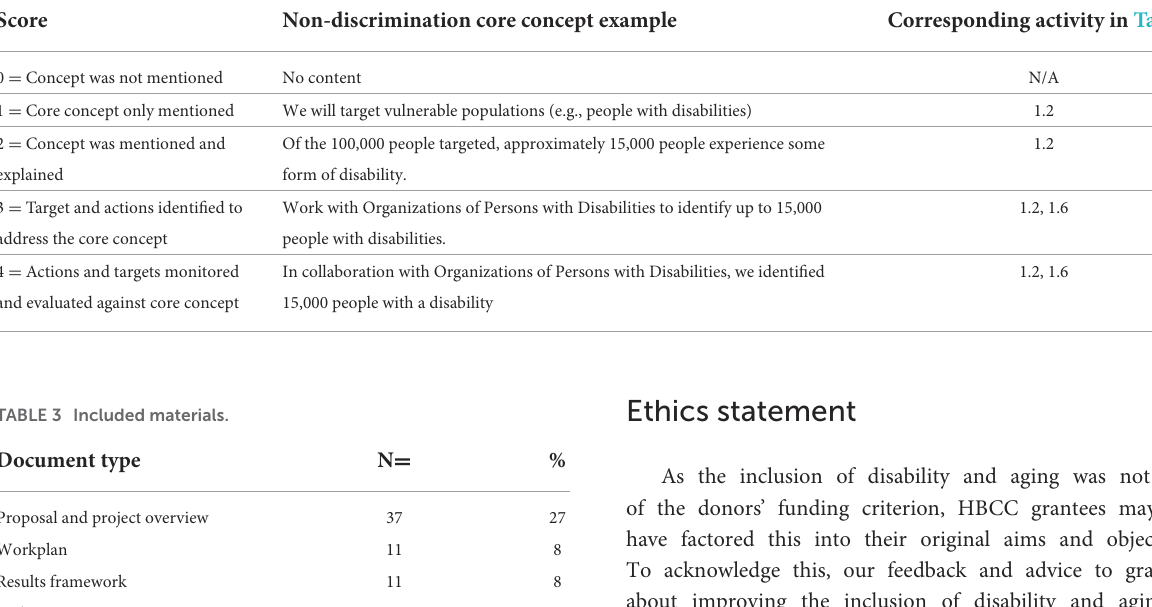
TABLE 2 Examples of project activities and how they would be scored against non-discrimination for